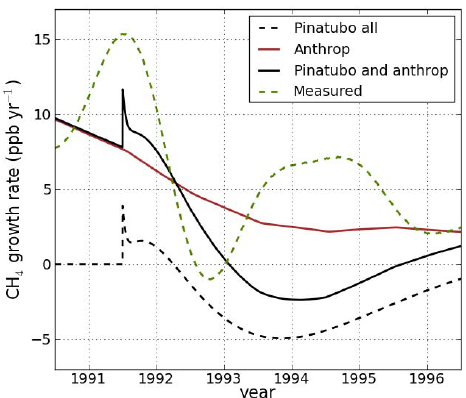
Fig. 7. Modelled growth rate evolution after the Pinatubo eruption including variations due to anthropogenic emissions, and the com- bined signal from natural and anthropogenic changes. The black dotted line shows the growth rate evolution obtained in the first set of simulations, including all natural forcings (the same as the black line in Fig. 6b). Also shown is the measured globally av- eraged growth rate obtained using the reference marine boundary layer matrix from GLOBALVIEW-CH4